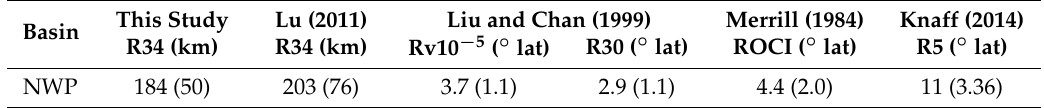
Table 3. Mean TC size obtained from this study and from that of Liu and Chan [4], Lu et al.